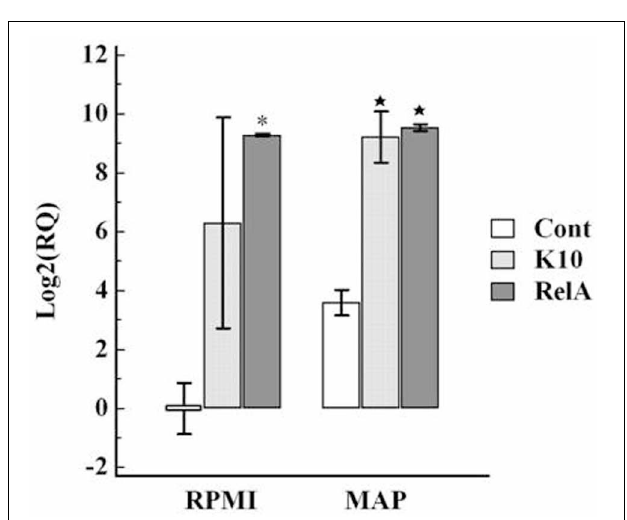
FIGURE 10 | Relative transcription of the granulysin gene in PBMC. The relative quantification of mRNA transcription was determined as described in the legend of Figure 7 . RQ, relative quantification; RPMI and MAP , PBMC cultured in RPMI medium alone and with live Map , respectively; ∗ and (cid:2) , significant difference compared to RPMI and MAP of the control group,